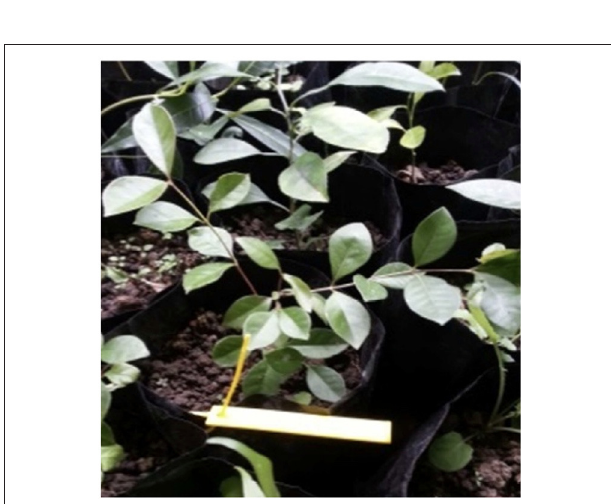
FIGURE 4 | The fruit tree used for object B in the KCK condition.